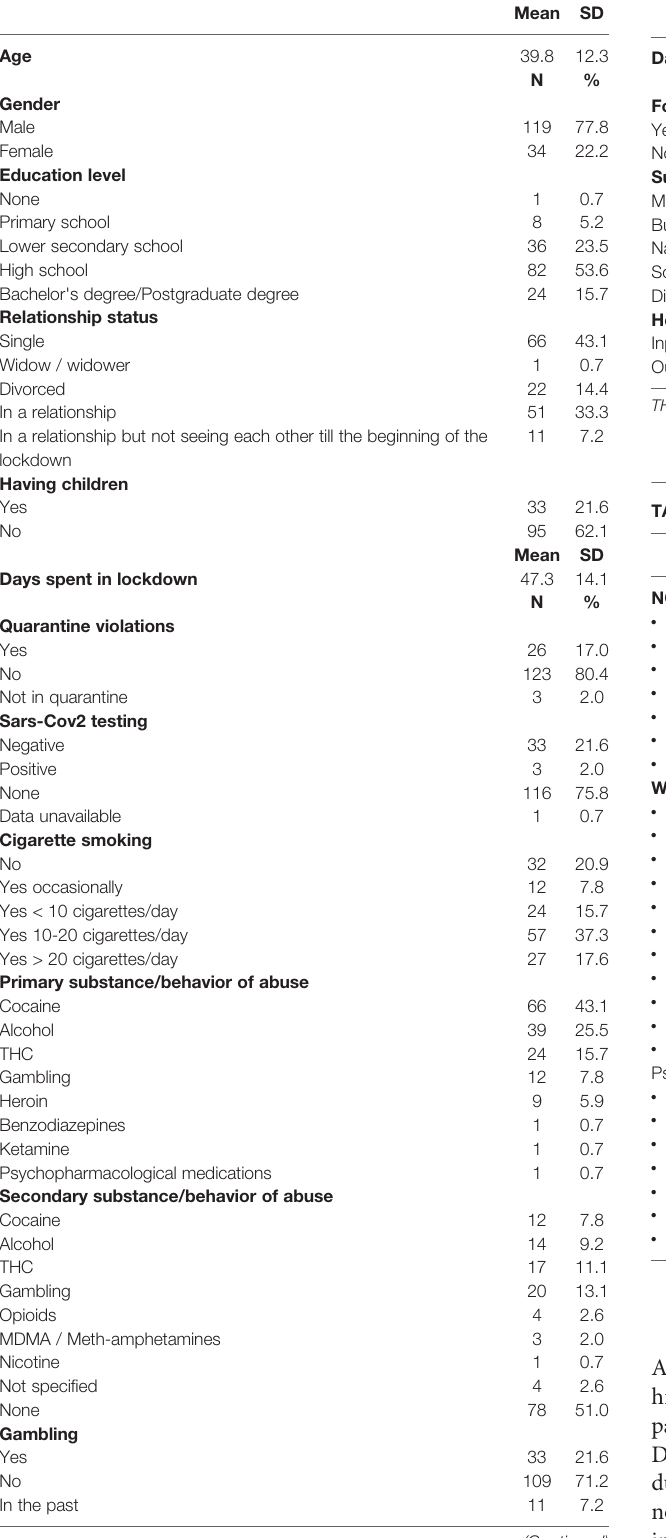
TABLE 1 | Participant ’ s characteristics and pattern of substance use.